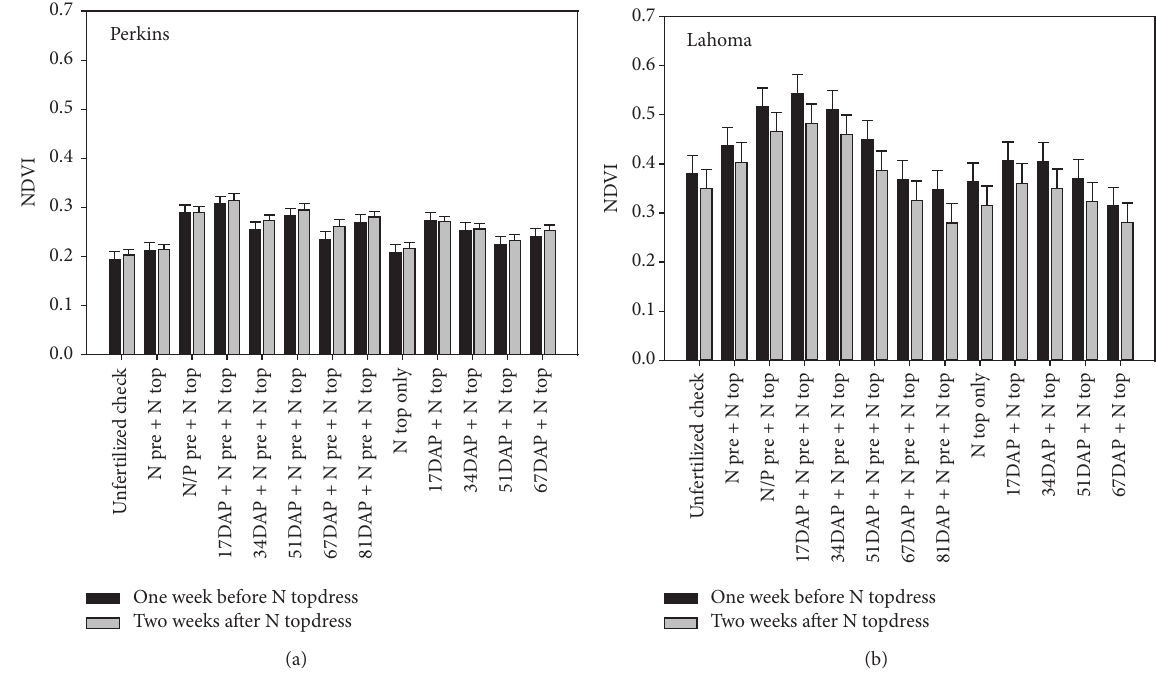
Figure 2: Normalized difference vegetation index (NDVI) values at one week before and two weeks after topdress nitrogen (N) as influenced by seed-placed diammonium phosphate (DAP) and N application method at Lahoma and Perkins, OK, in 2011-2012; pre: preplant; top: topdress.